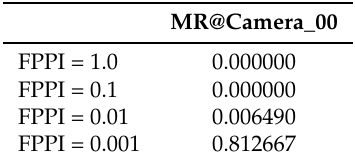
Table 1. Accuracy table @ Camera_00, informed-filters.